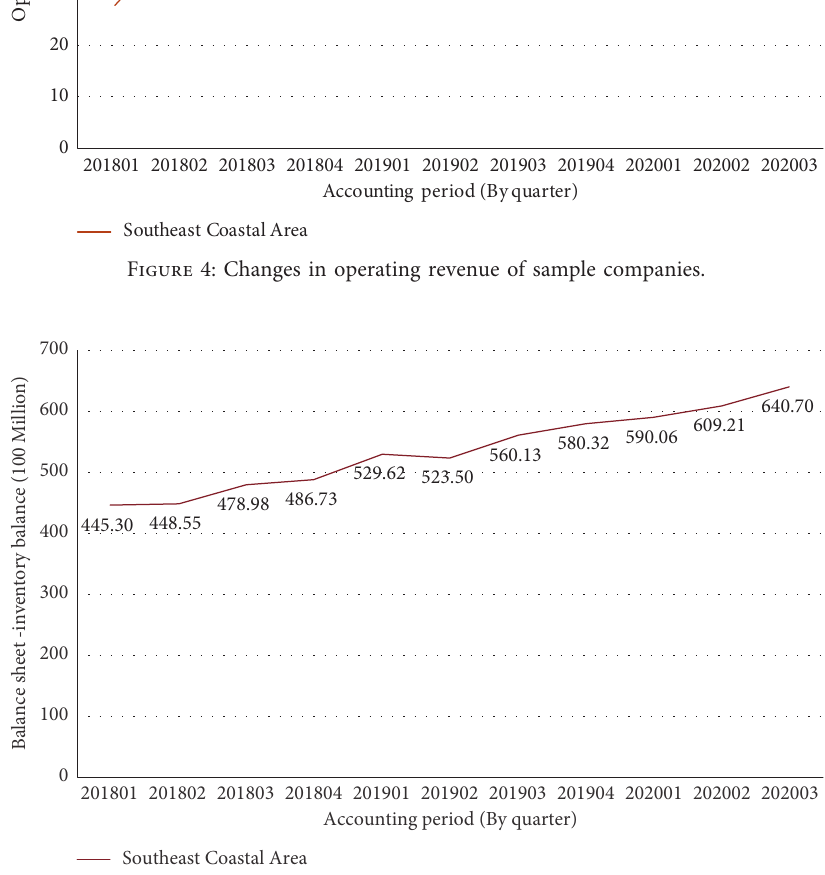
Figure 5: Changes in inventory balances of sample